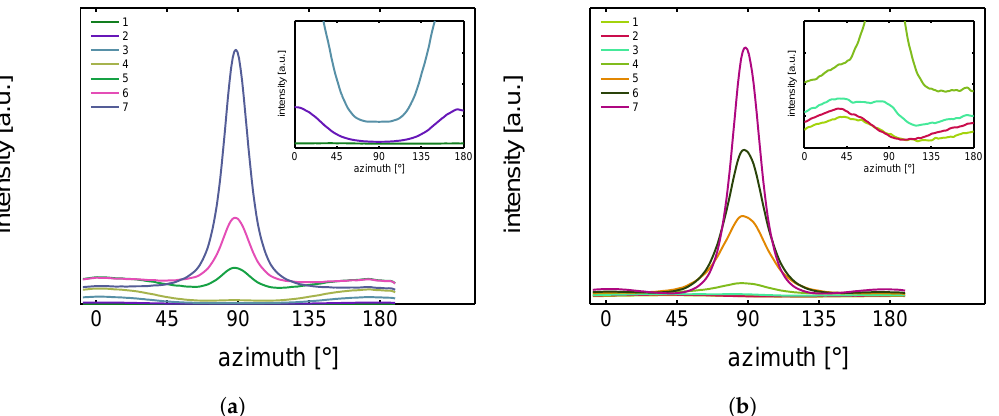
Figure 24. Azimuthal intensity of the lamellar scattering at various strains of β -iPP. ( a ) uni-axial stretching at 25 ◦ C and ( b ) 110 ◦ C. The numbers in the legend correspond to the 2D patterns in Figure 23.